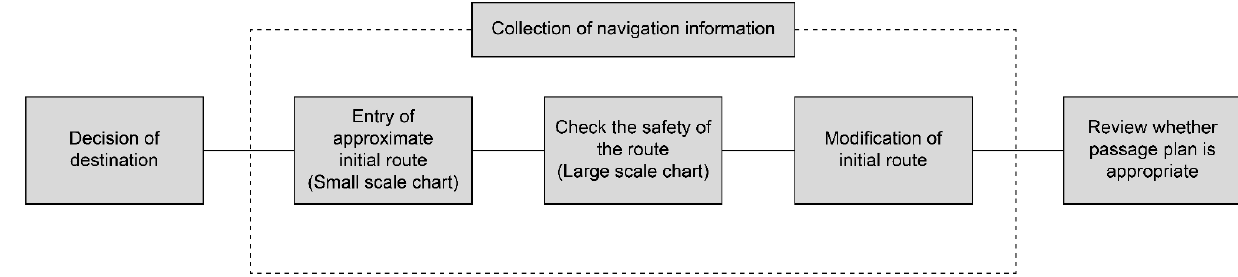
Figure 1. The navigator’s route planning process.